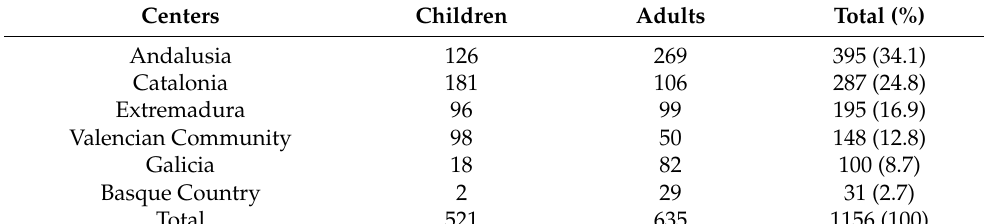
Table 1. Distribution of patients included in the study by center.